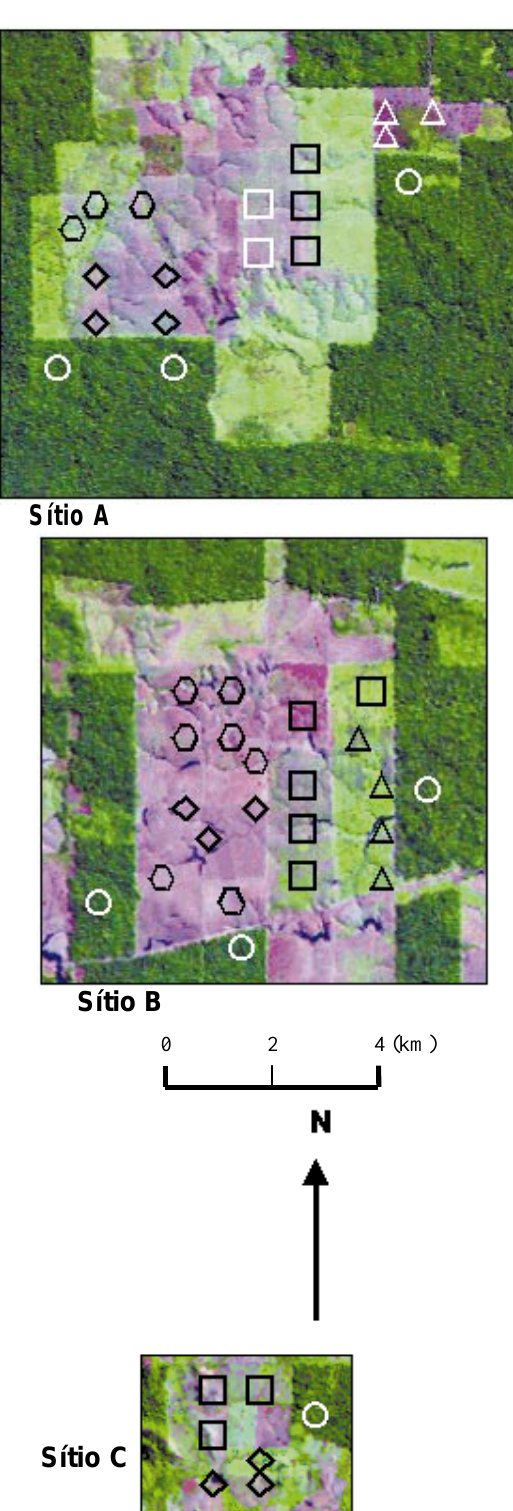
Figura 1. Mapa de amostragem. As marcas nos sítios referem-se aos pontos de amostras